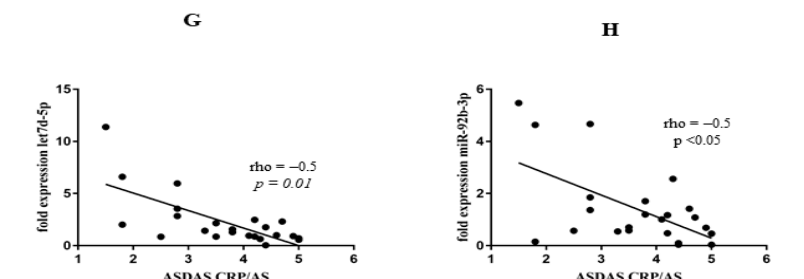
Figure 3. Correlation analyses of miR expression and disease activity scores in PsA group of patients ( A – F ) and AS group of patients ( G , H ).